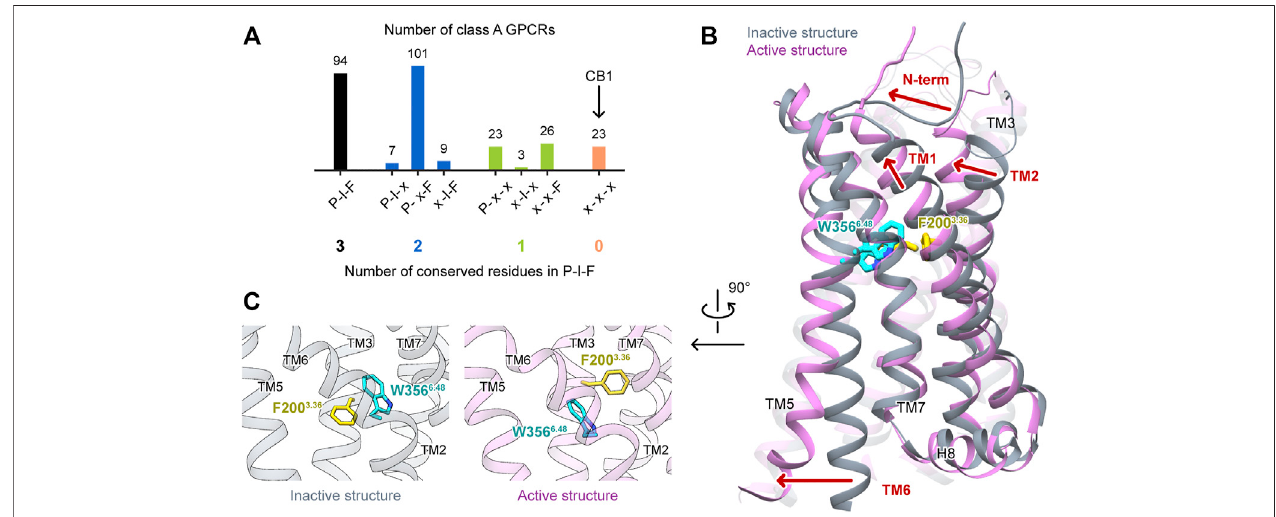
FIGURE 1 | Special features of CB1 activations among class A GPCRs. (A) Conservativeness of the P-I-F motif in nonolfactory class A GPCRs (colored according to the number of conserved residues). CB1 is among the 23 members possessing none of P 5.50 , I 3.40 , and F 6.44 . (B) Comparison of CB1 inactive and active structures, showing movements of structural segments. (C) Side-chains of F200 3.36 and W356 6.48 in inactive and active structures of CB1 showed “ twin toggle switch ” of the two residues, a remarkable conformational change.